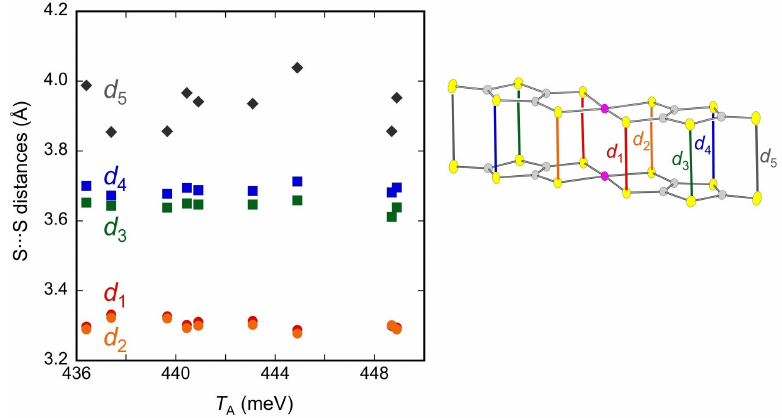
and intermolecular S···S distances (Å) responsible for T A